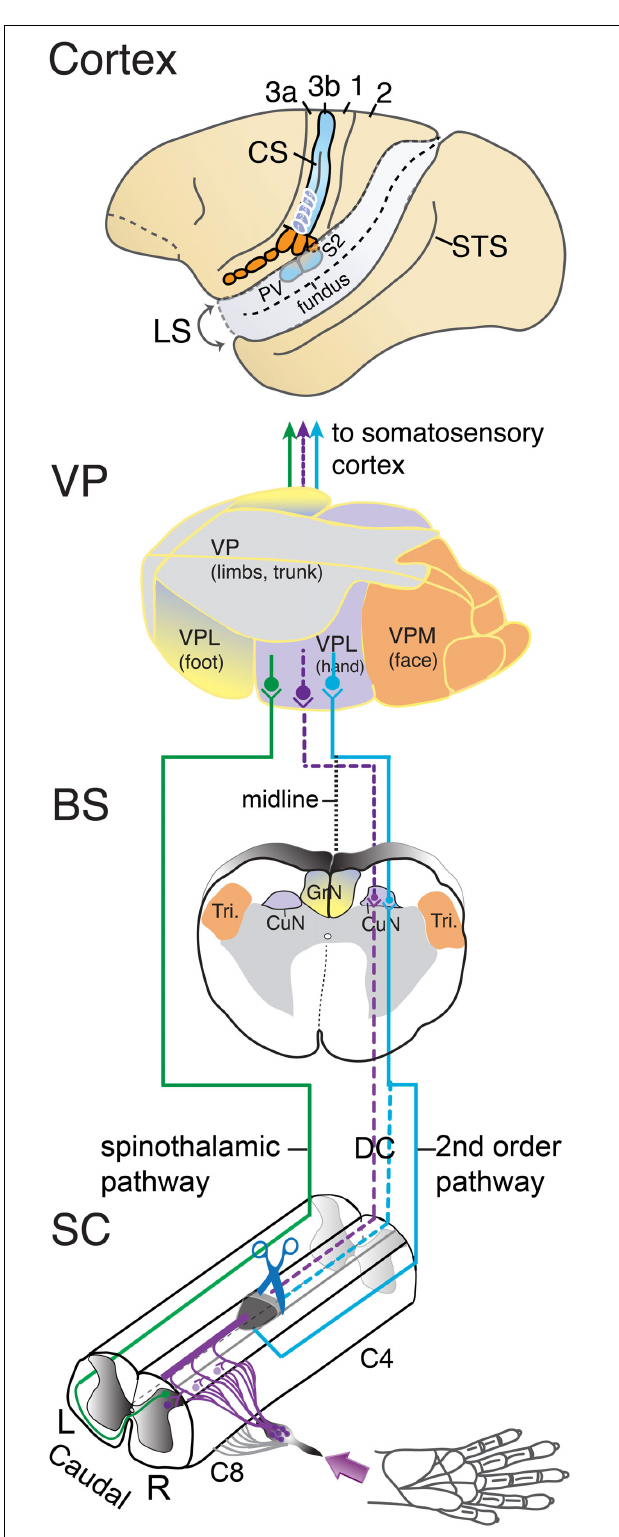
FIGURE 1 | Somatosensory pathways from the spinal cord to cortex of a squirrel monkey. Cutaneous afferents from the hand that enter the cervical spinal cord between C4 and C8 levels via the dorsal roots are